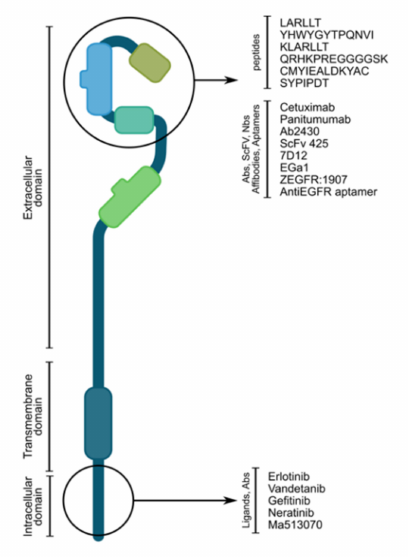
Figure 8. Domains of EGFR recognized by different targeting agents. Created with